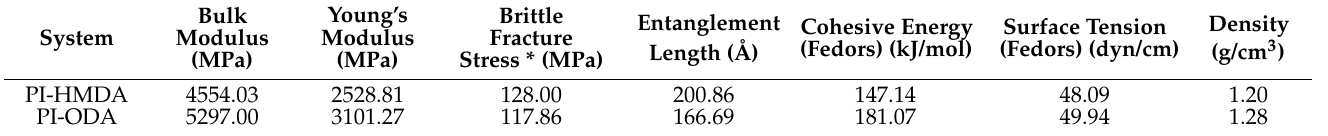
Surface Tension (Fedors) (dyn/cm)